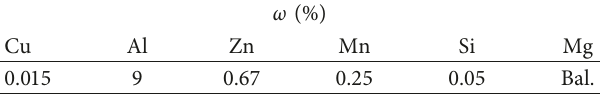
Table 1: Chemical composition of AZ91D